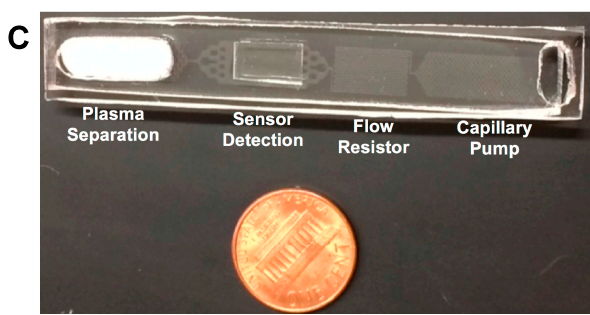
Figure 1. ( A ) Schematic diagram of an assembled lateral flow device (LFD) for detection of single biomarker in whole blood sample. The black arrows indicate the flow direction; ( B ) Schematic diagram shows interfacing layer and fluid layer of the LFD. The first capillary pump (CP1) is partially covered by a plasma separation membrane, and it is designed for plasma extraction, while the second capillary pump (CP2) is designed to assist the fluid flow. Surface-immunoassays can be performed directly on the sealed chip on top of the detection chamber area; ( C ) A picture shows the fabricated LFD with the same design in Figure 1A.